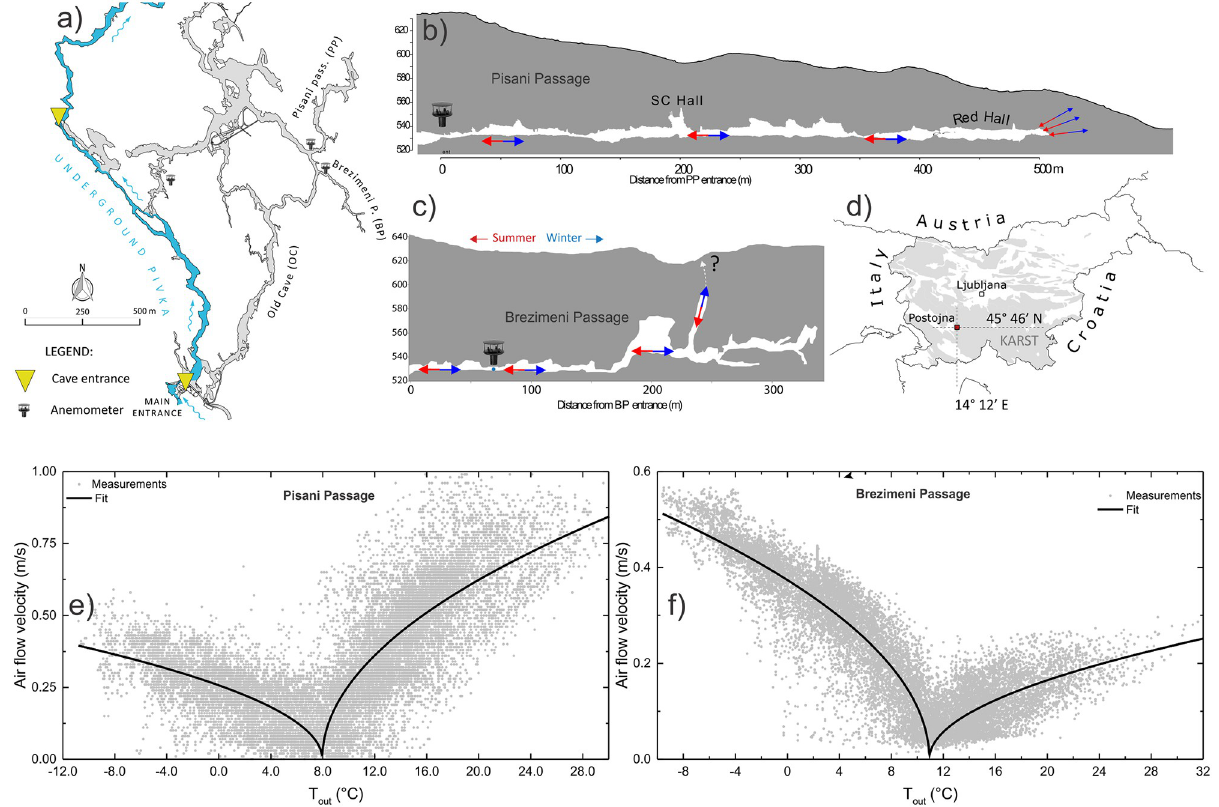
Fig 3. Map of the Postojna cave. (a) and simplified profiles of Pisani Passage (b) and Brezimeni Passage (c). Arrows in profiles indicate the direction of airflow in winter (blue arrows) and summer (red arrows) d) Geographic position of Postojna. e) Relation between airflow velocity in Pisani Passage and outside temperature. f) Relation between airflow velocity in Brezimeni Passage and outside temperature. Grey dots present a point cloud of two years of measurements and the black line is the square root fit. Figures a, b, c and d adopted from [14].